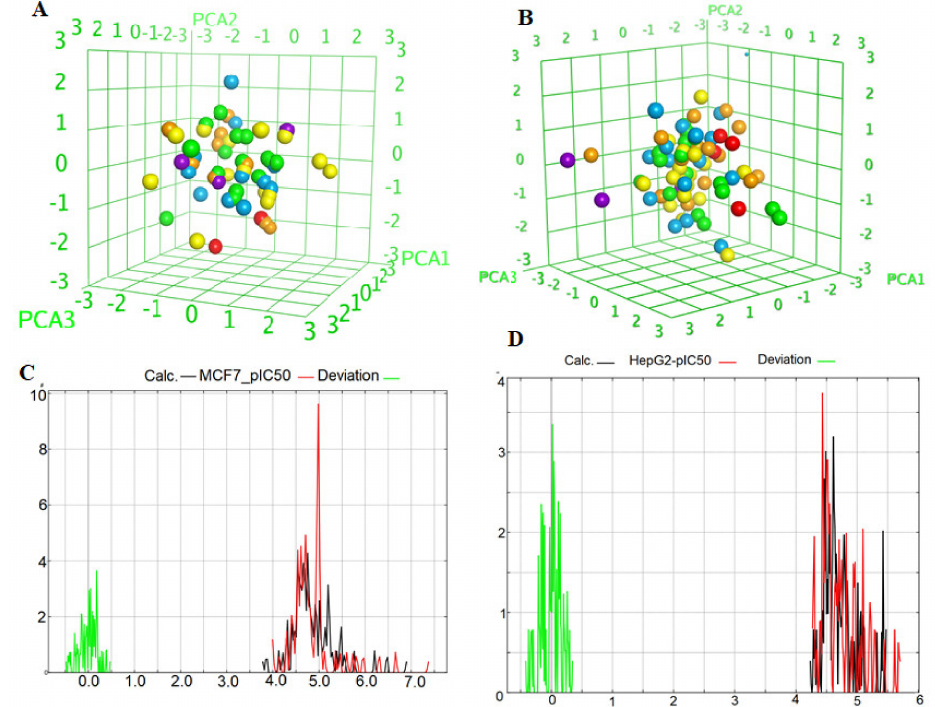
Figure 10. ( A , B ) 3D chemical space plot of the selected training compounds of HepG2 and MCF-7 divided by the important descriptors; ( C , D ) Curve plot of the training set for MCF-7 and HepG2 ( n = 10), p IC50 exp: red curve; p IC50 cal: black curve; Deviation: green